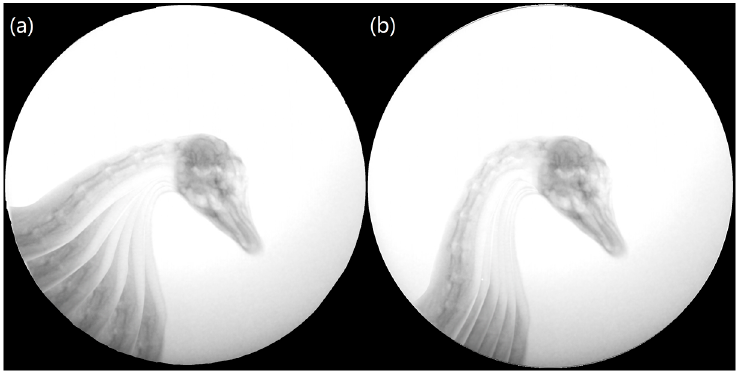
Figure 5. Motion synthesis diagram in X ‐ rays: ( a ) Goose moving in Y ‐ direction, ( b ) Goose moving in Z ‐ direction.